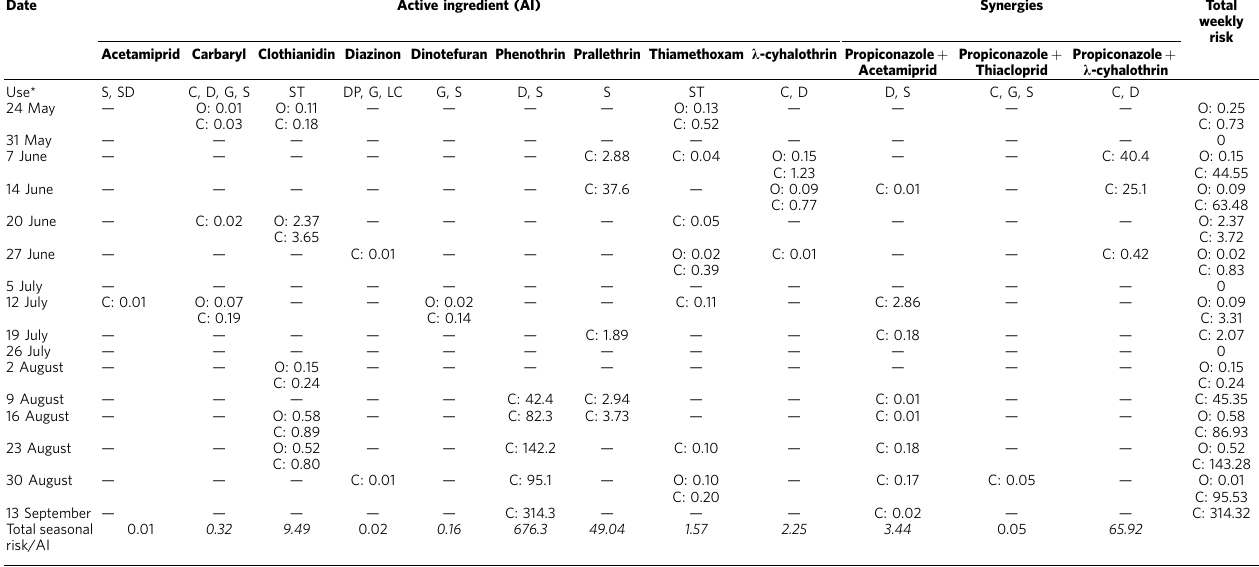
Table 5 | The average risk (%) posed by pesticide residues in pollen collected by honey bees placed next to a pesticide-treated maize